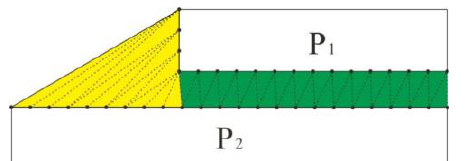
Figure 5. Effective connectable (green) and invalid connectable (yellow)